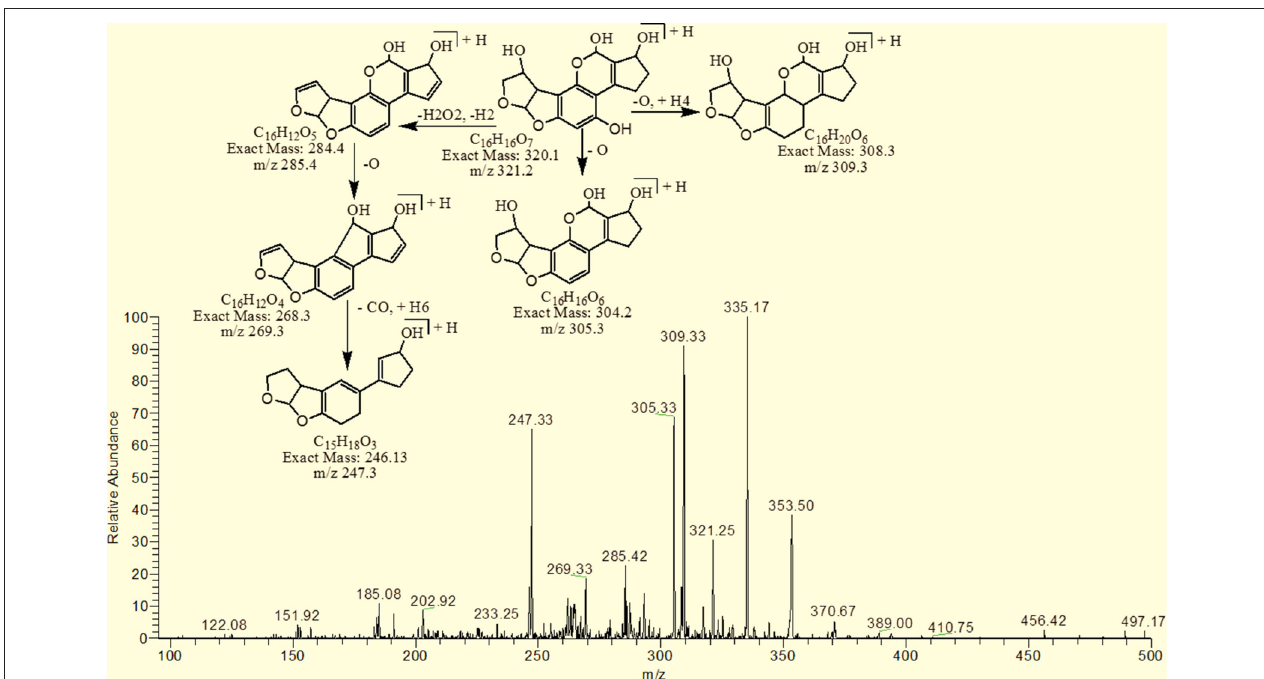
FIGURE 6 | MS/MS spectra and fragmentation pathway of degradation product with